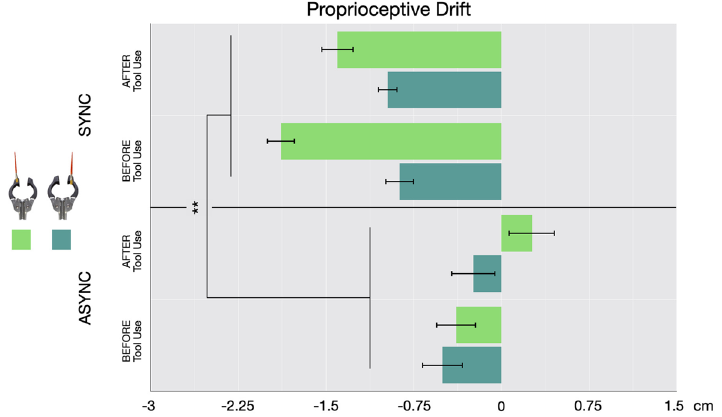
Figure 3. In Experiment 2, participants (N = 40) perceived their index finger drifted toward the tool only after synchronous (upper panel), but not after asynchronous (lower panel), brushing. Error bars indicate 95%